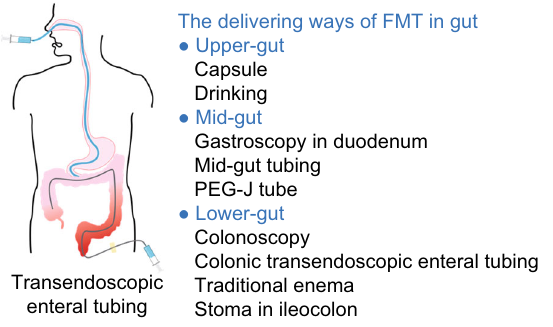
Figure 2. The delivering ways of microbiota transplantation in gastrointestinal tract.